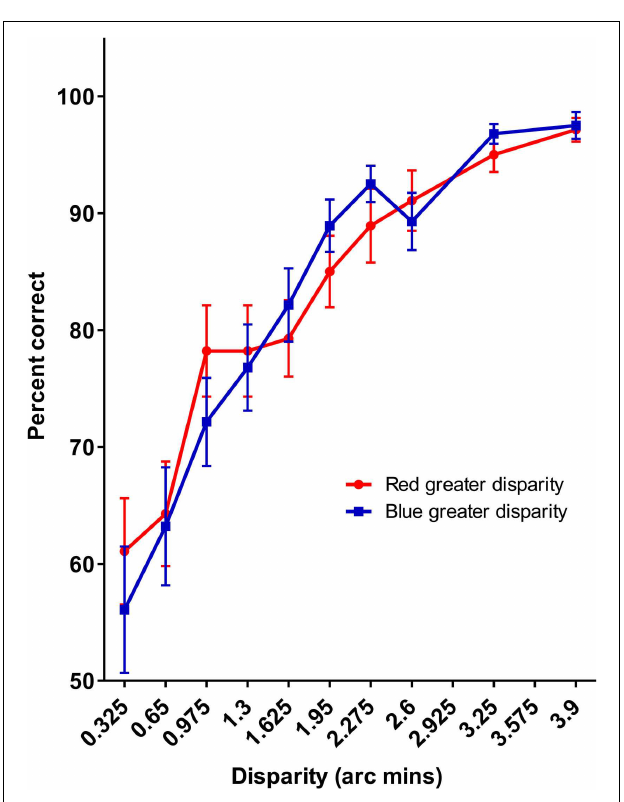
FIGURE 7 |The averaged results of Experiment 2. No differences between the red and blue stimuli are